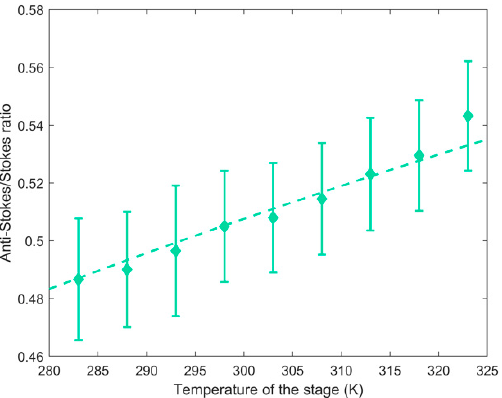
Figure A2. Experimental anti-Stokes/Stokes ratios (green diamonds) of the 143 cm − 1 E g mode of anatase as a function of the temperature, and corresponding calibration curves (dashed line); data are collected by exciting at 514.5 nm.